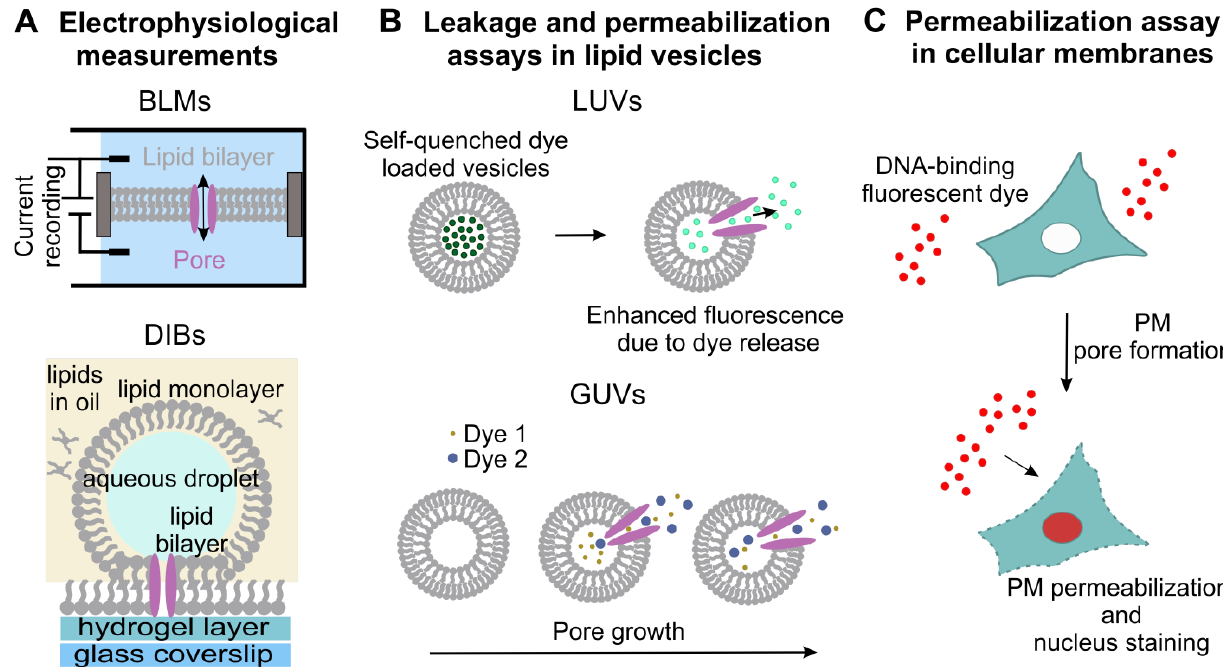
Figure 5. Methods used to evaluate pore functionality. ( A ) Electrophysiological measurements of currents generated by pore formation can be detected in different membrane model systems, such as planar membranes ( top ) or DIBs ( bottom ). ( B ) Free-standing vesicles are used in permeabilization assays with recombinant proteins (see text for details). ( C ) In cells, membrane-impermeant dyes binding to DNA are used as markers of membrane permeabilization of the PM.